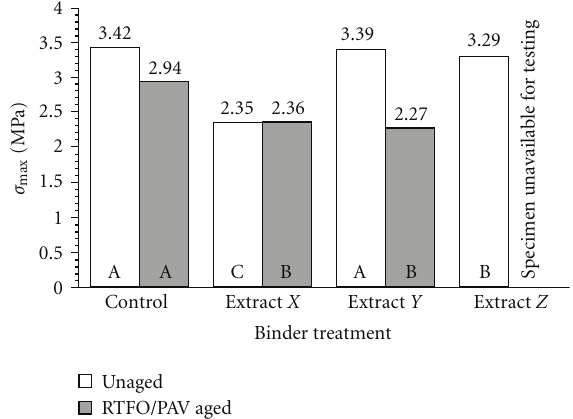
Figure 16: Elastic modulus of original and PAV aged control binder and binder with finish extracts tested at − 12 ◦